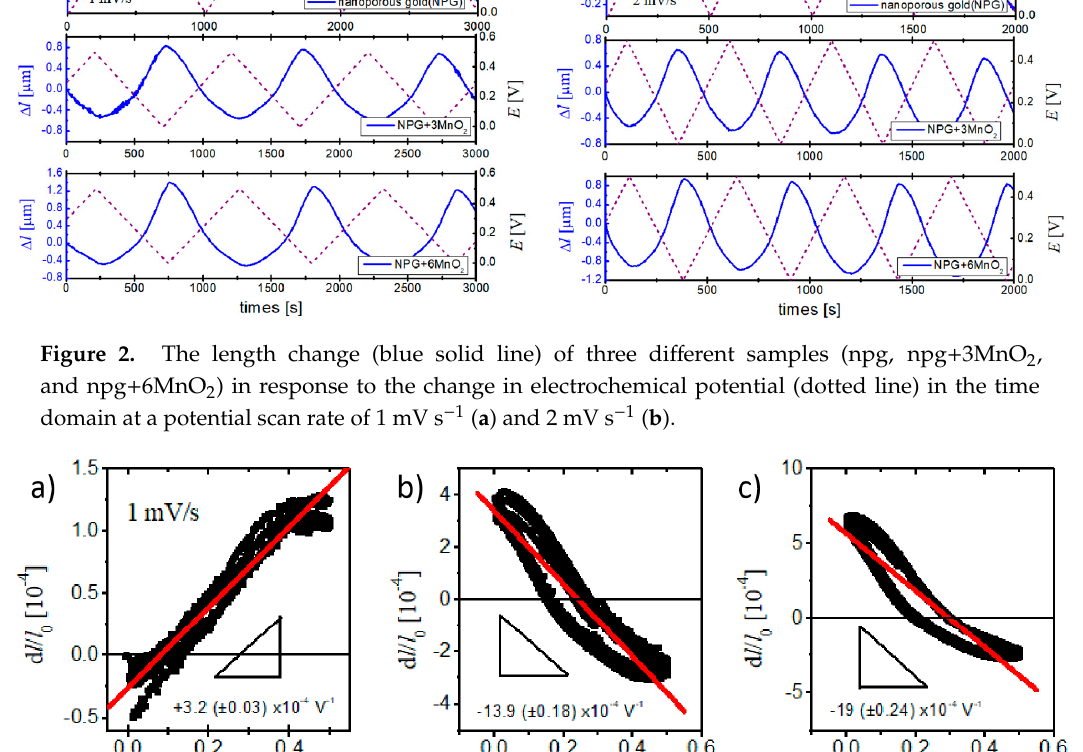
Figure 2. The length change (blue solid line) of three different samples (npg, npg+3MnO 2 , and npg+6MnO 2 ) in response to the change in electrochemical potential (dotted line) in the time domain at a potential scan rate of 1 mV s − 1 ( a ) and 2 mV s − 1 ( b ).